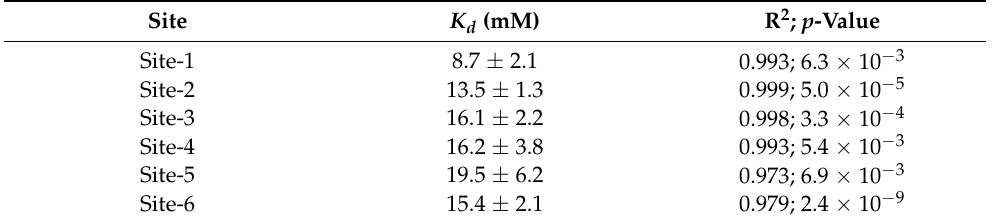
Table 1. CSP fitting parameters obtained using Equation (1) for the binding sites inferred from NMR